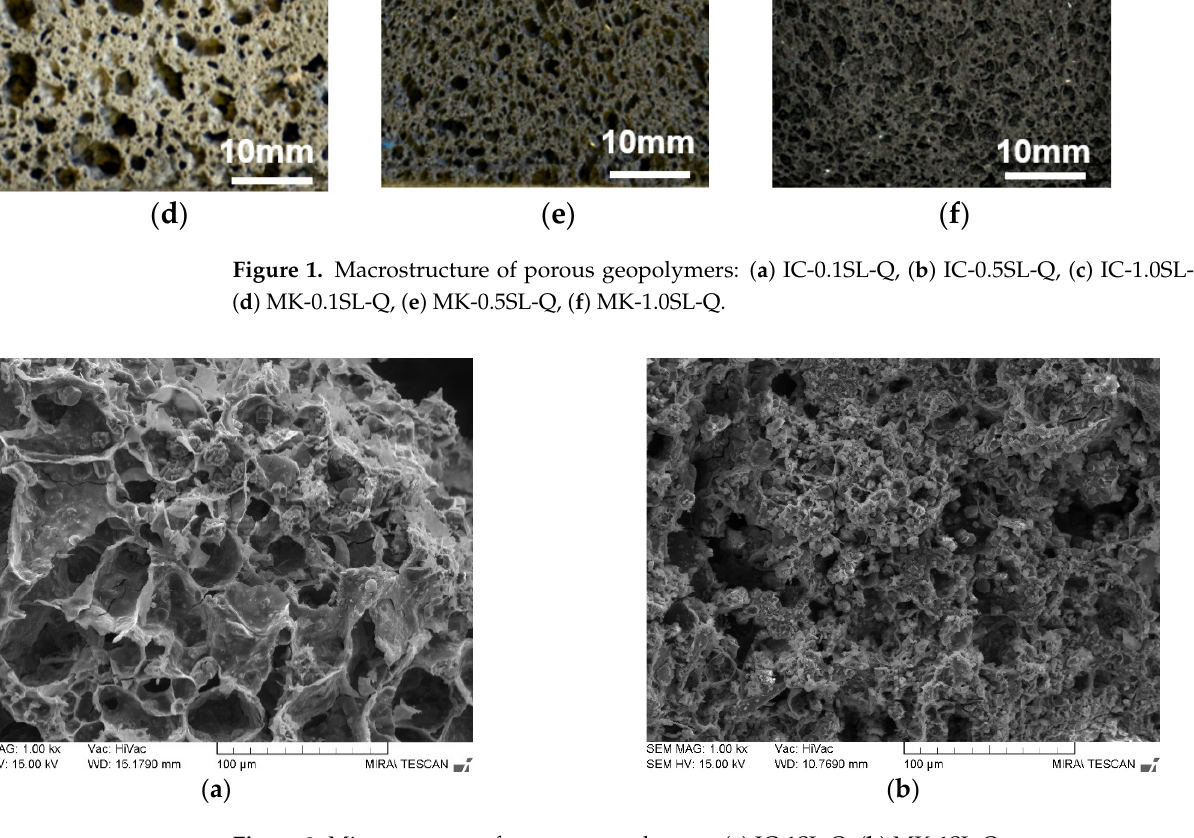
Figure 1. Macrostructure of porous geopolymers: ( a ) IC-0.1SL-Q, ( b ) IC-0.5SL-Q, ( c ) IC-1.0SL-Q, ( d ) MK-0.1SL-Q, ( e ) MK-0.5SL-Q, ( f ) MK-1.0SL-Q.